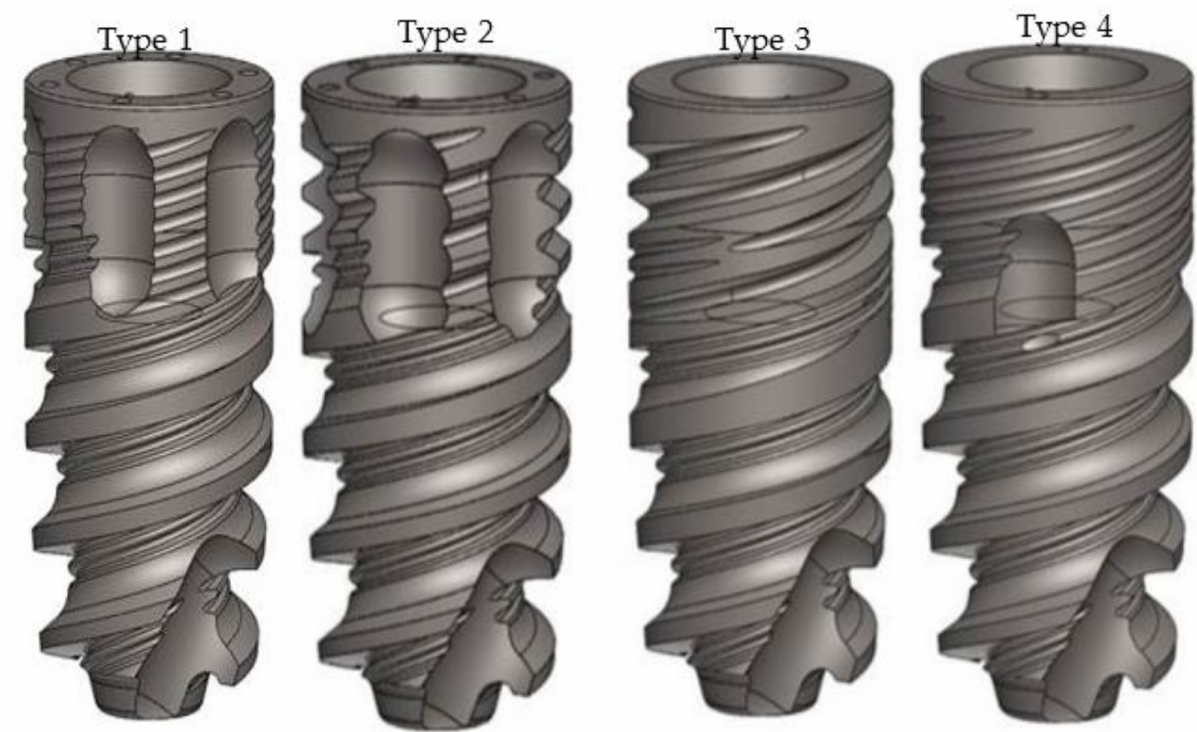
Figure 1. The four types of NeO ® implants inserted: Type 1—implant with 6 coronal flutes and 8 shallow microthreads. Type 2—implant with 6 coronal flutes and 4 deep microthreads. Type 3—implant with 0 coronal flutes and 4 deep mi- crothreads. Type 4—implant with 2 shorter coronal flutes and 8 shallow